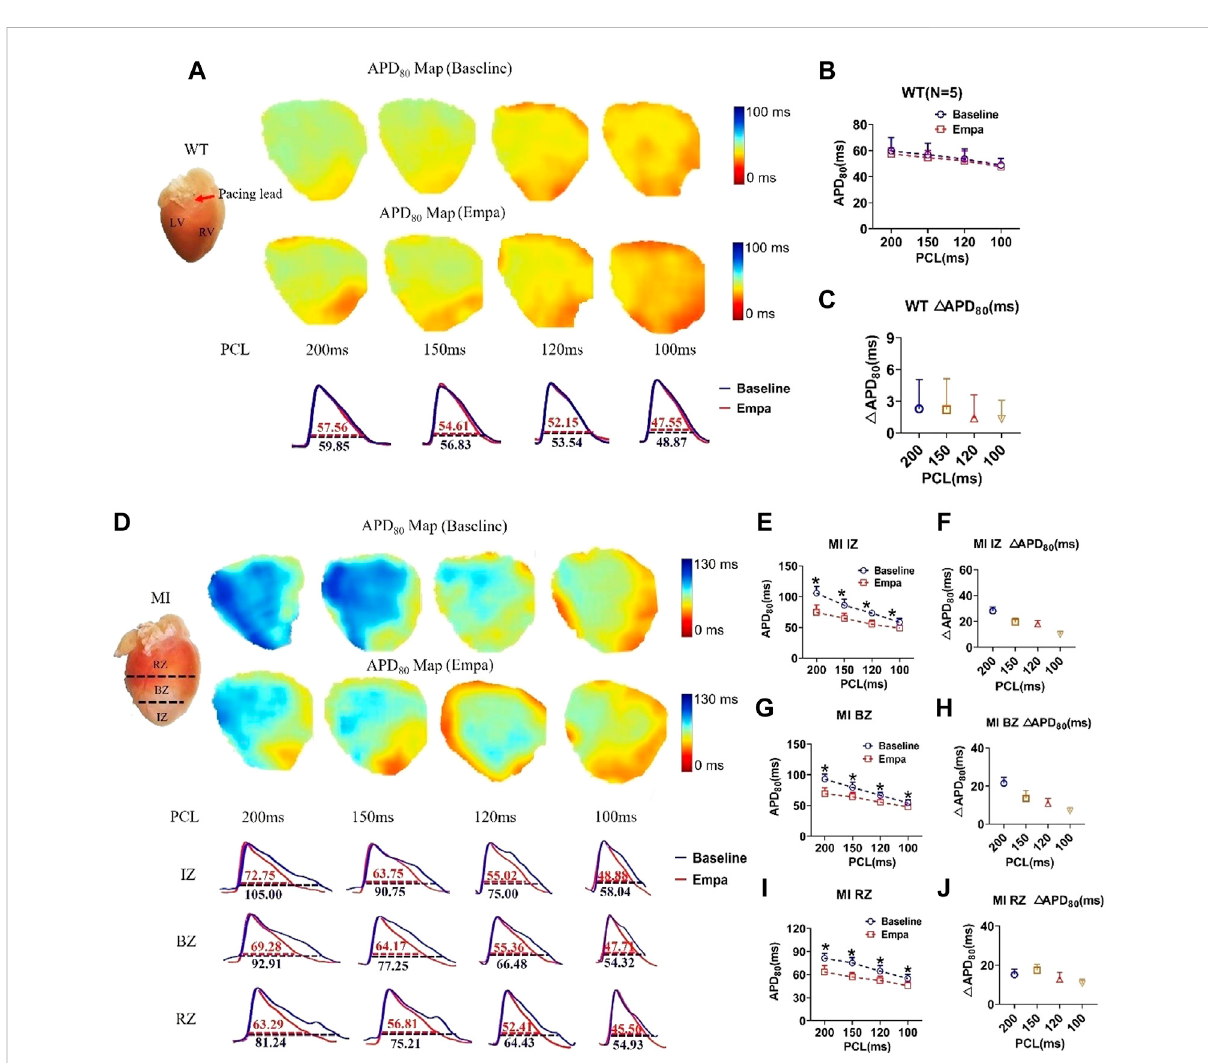
FIGURE 2 Effects of EMPA on action potential duration (APD) at different pacing cycle lengths (PCLs) in normal and infarcted hearts. (A) Representative membrane potential traces and APD at 80% repolarization (APD 80 ) maps at baseline and in the presence of EMPA (10 nmol/L) in normal ventricles. (B,C) APD 80 and Δ APD 80 associatedwithdifferentPCLsatbaselineandafterEMPAinfusioninnormalventricles. N =5. (D) Representativemembrane potential traces and APD at 80% repolarization (APD 80 ) maps at baseline and in the presence of EMPA (10 nmol/L) in IZ, BZ, and RZ zones of infarctedhearts (E,F) APD 80 and Δ APD 80 associatedwithdifferentPCLsatbaselineandafterEMPAinfusionininfarctedventriclesofIZ. N =9 – 12.* p < 0.05 vs . baseline, p -values were determined by unpaired t test. (G,H) APD 80 and Δ APD 80 associated with different PCLs at baseline and after EMPA infusion in infarcted ventricles of BZ. N = 10 – 12. * p < 0.05 vs . baseline. (I,J) APD 80 and Δ APD 80 associated with different PCLs at baseline and after EMPA infusion in infarcted ventricles of RZ. N = 9 – 11. * p < 0.05 vs .